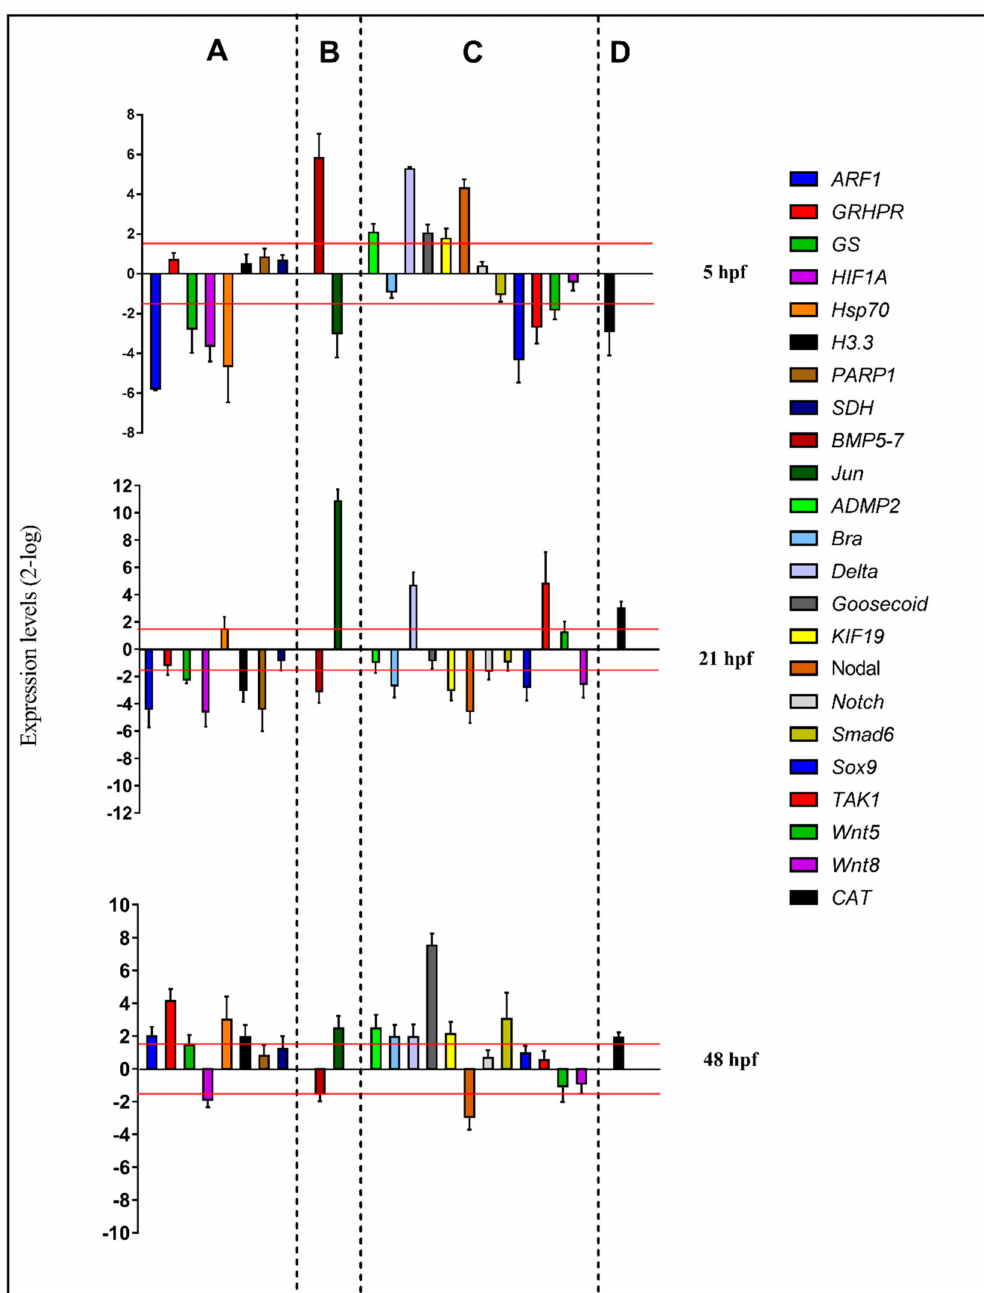
Figure 3. Real-time qPCR at the blastula (5 hpf), gastrula (21 hpf), and pluteus (48 hpf) stages of the sea urchin P. lividus . Histograms show the fold-changes of 23 genes involved in di ff erent functional processes: stress ( A ), skeletogenesis ( B ), development / di ff erentiation ( C ), and detoxification ( D ). Fold di ff erences greater than ± 1.5 (see red dotted horizontal guidelines at values of + 1.5 and − 1.5) were considered